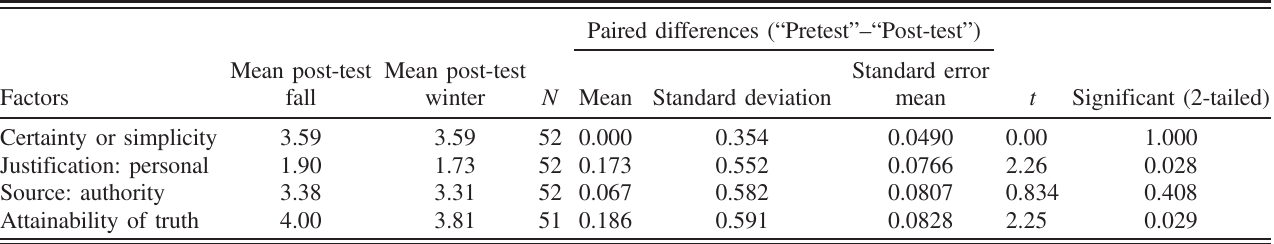
TABLE XI. The results of paired t test for the control group at the end of the winter semester 2015 compared to the end of the fall semester 2014 (pretest).